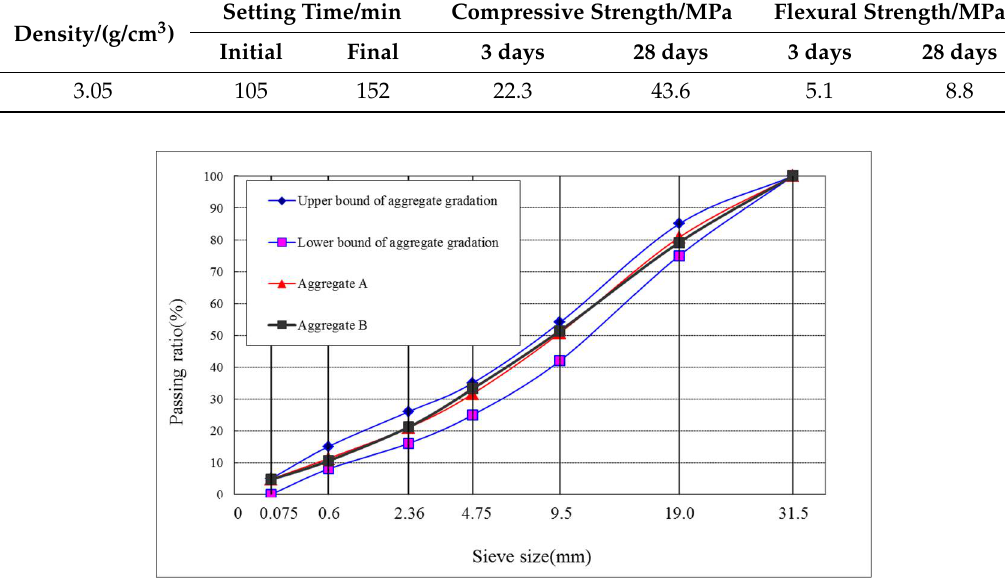
Table 2. Properties of the cement.